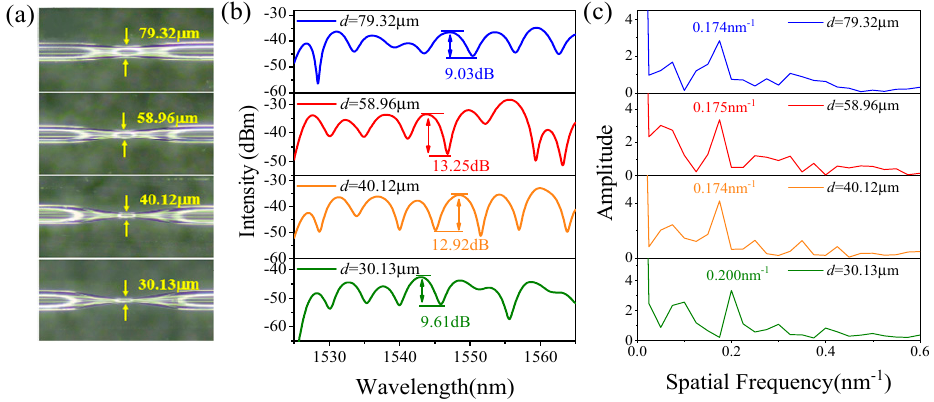
Figure 4. ( a ) The micro-images, ( b ) transmission and ( c ) spatial frequency spectra of t -TCF structures with the varied d .